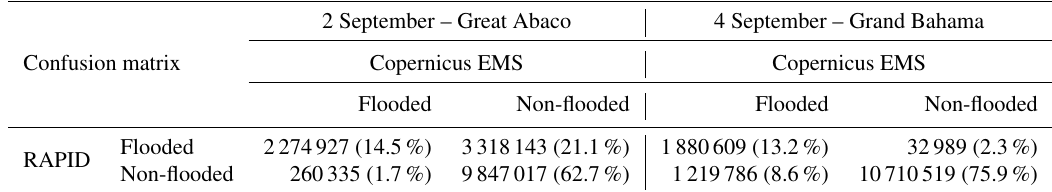
Table 1. Confusion matrix between RAPID and Copernicus EMS flooding products for the 2 September 2019 overpass over Great Abaco (left) and for the 4 September 2019 overpass over Grand Bahama (right). For each matrix, number and percentage of pixels are